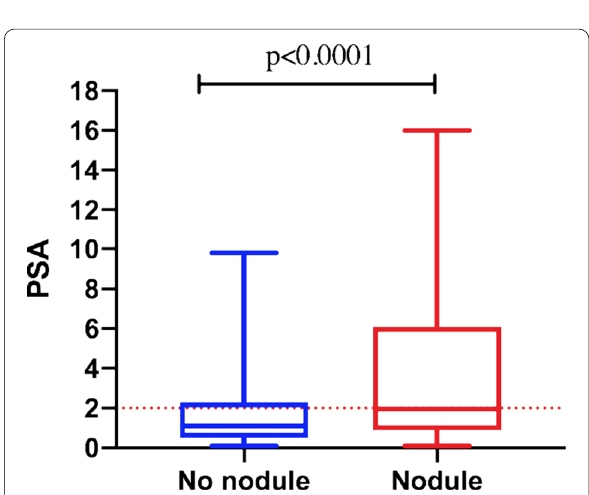
Fig. 5 Box and Whisker plot demonstrating participants’ PSA levels for those with nodules and those without